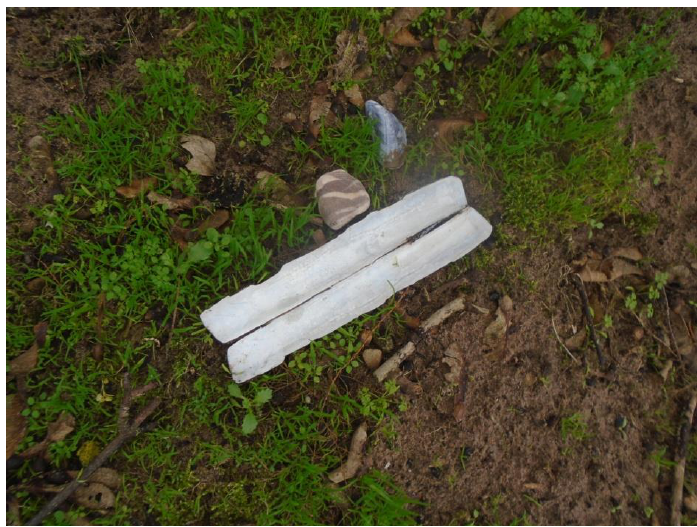
Figure 18. Razor shell.